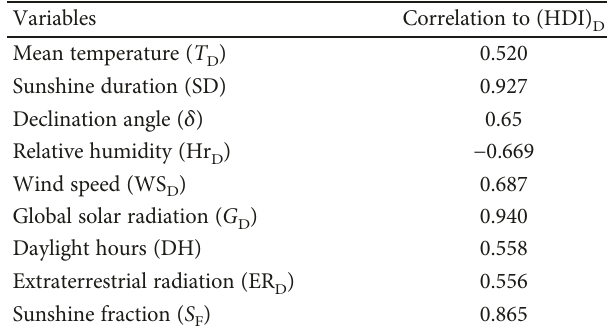
Table 4: Correlation of di ff erent parameters to (HDI)